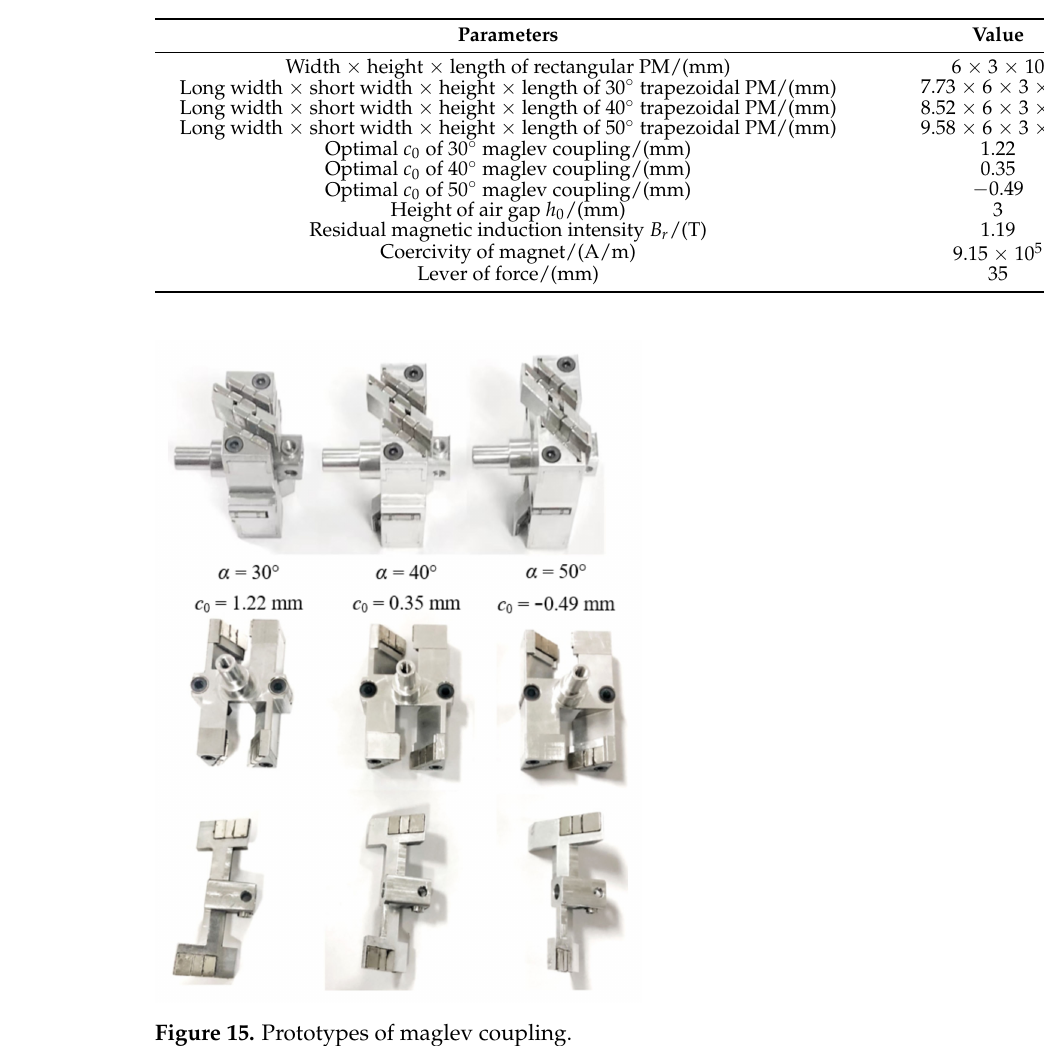
Table 4. Design structure parameters for maglev prototypes.